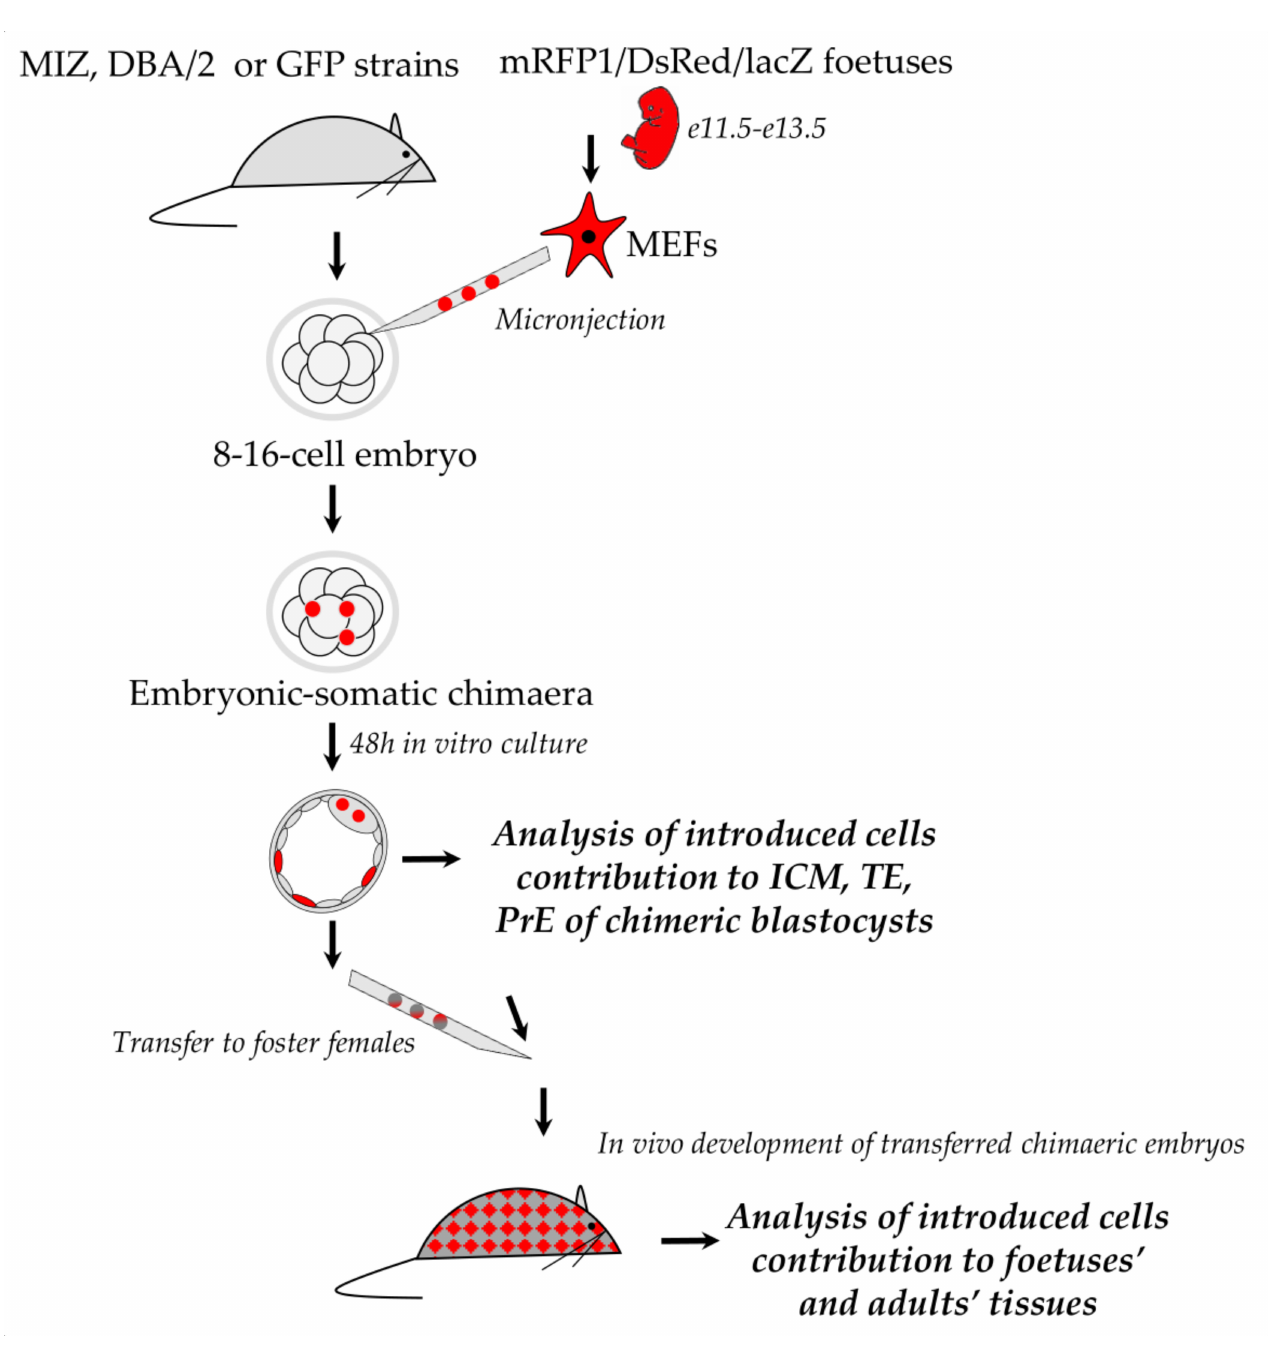
Figure 1. Experimental outline. Figure shows general scheme of experiments performed in this